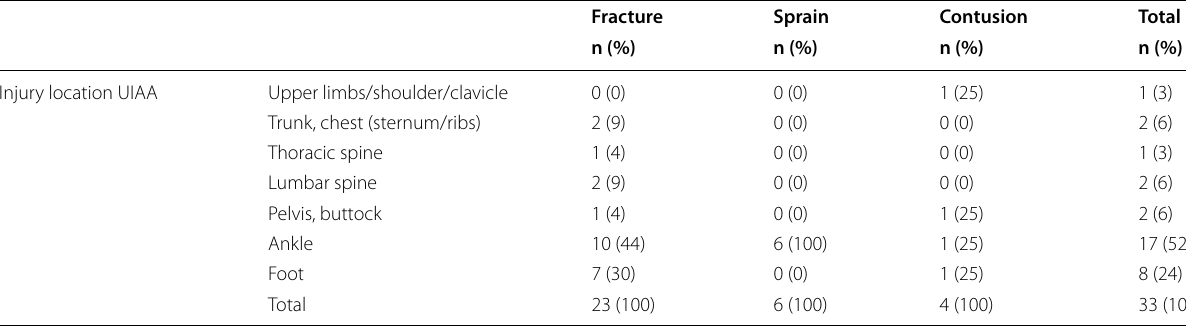
Table 3 Injury location of fractures, sprains and